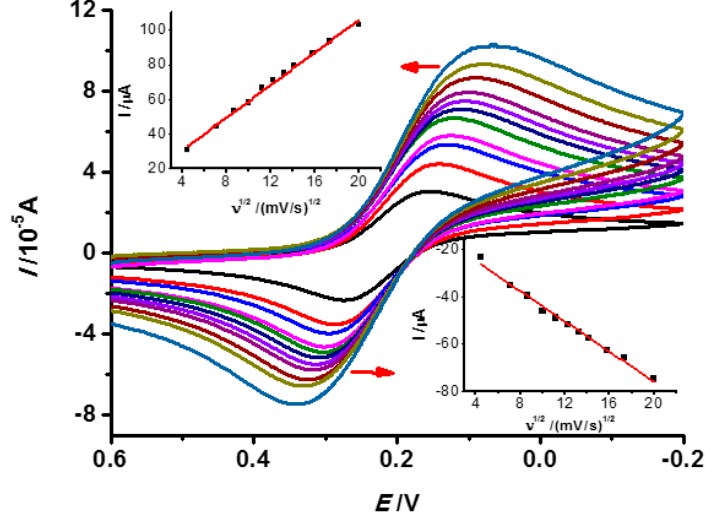
Figure 7. CV of the INS at various scan speeds of 20, 50, 75, 100, 125, 150, 175, 200, 250, 300, and 400 mV/s (from inner to outer), inset shows the calibration plot of I ~ v 1/2 .